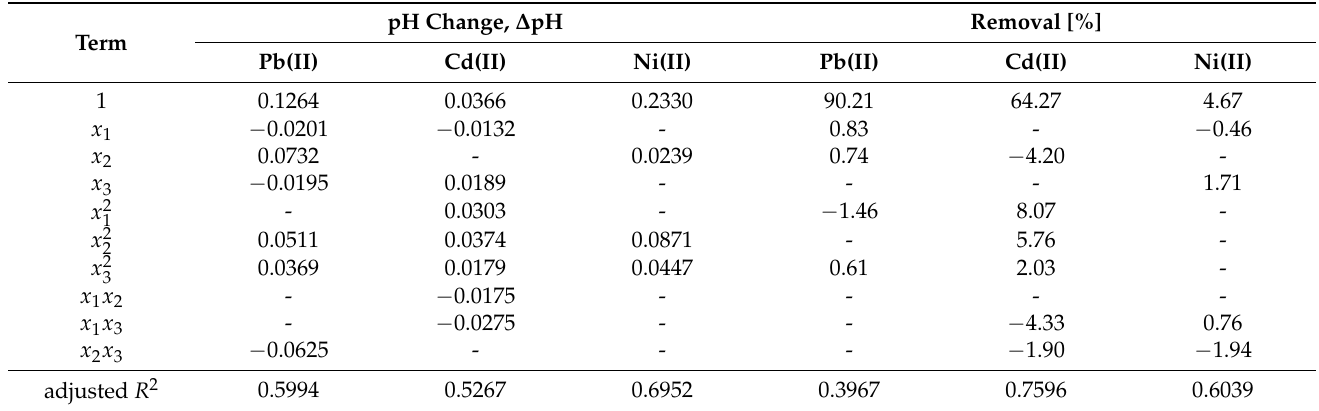
Table 5. Fitting parameters for metal ion removal and pH